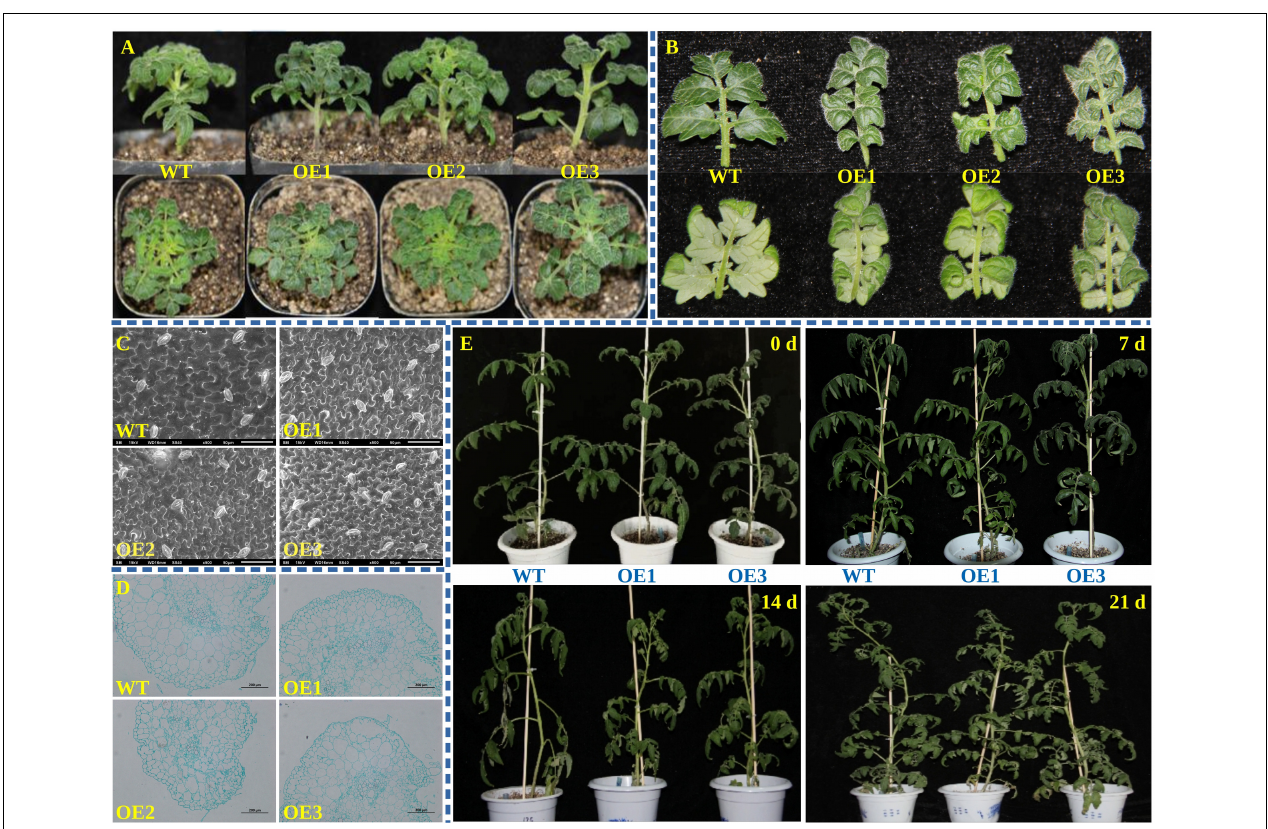
FIGURE 2 | Phenotypic analysis of transgenic tomato over-expressing PpOFP1. (A) Phenotypes of whole transgenic tomato under normal growth conditions. (B) Leaf phenotypes of transgenic tomato under normal growth conditions. (C) Scanning electron microscopy of leaf epidermal cell structure under normal growth conditions. (D) Cross-section of paraffin embedded stem cell tissue under normal growth conditions. (E) Phenotype of transgenic tomato under high salt stress.